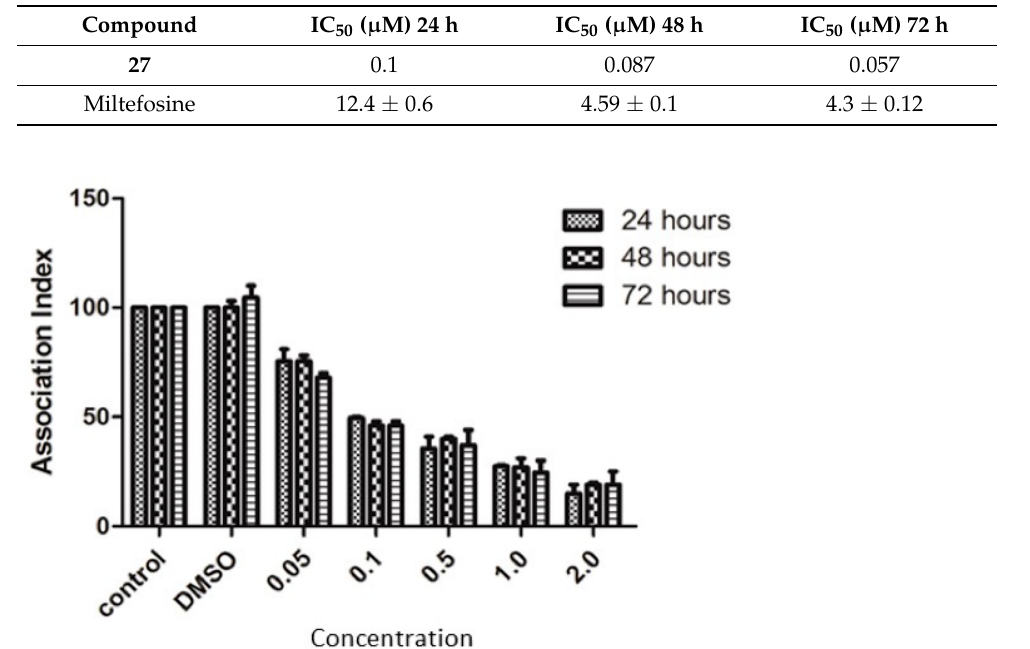
Figure 5. Treatment of peritoneal macrophages infected with intracellular amastigotes of T. cruzi with phospholipid 27 .